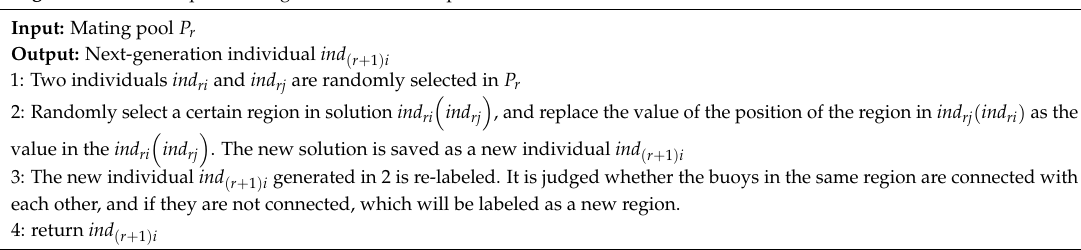
Algorithm 2: Cross operation algorithm for AB-Graph